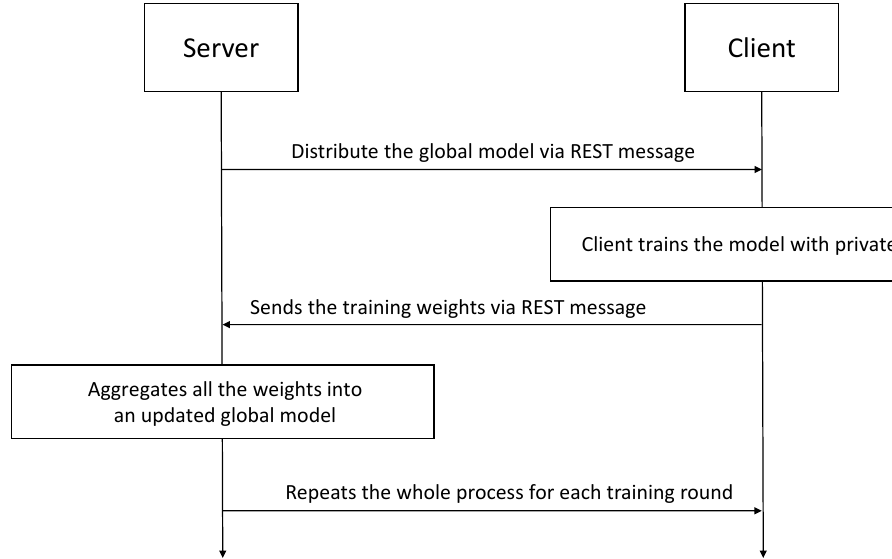
Figure 4. Federated Learning Server–Client Interaction in the Proposed